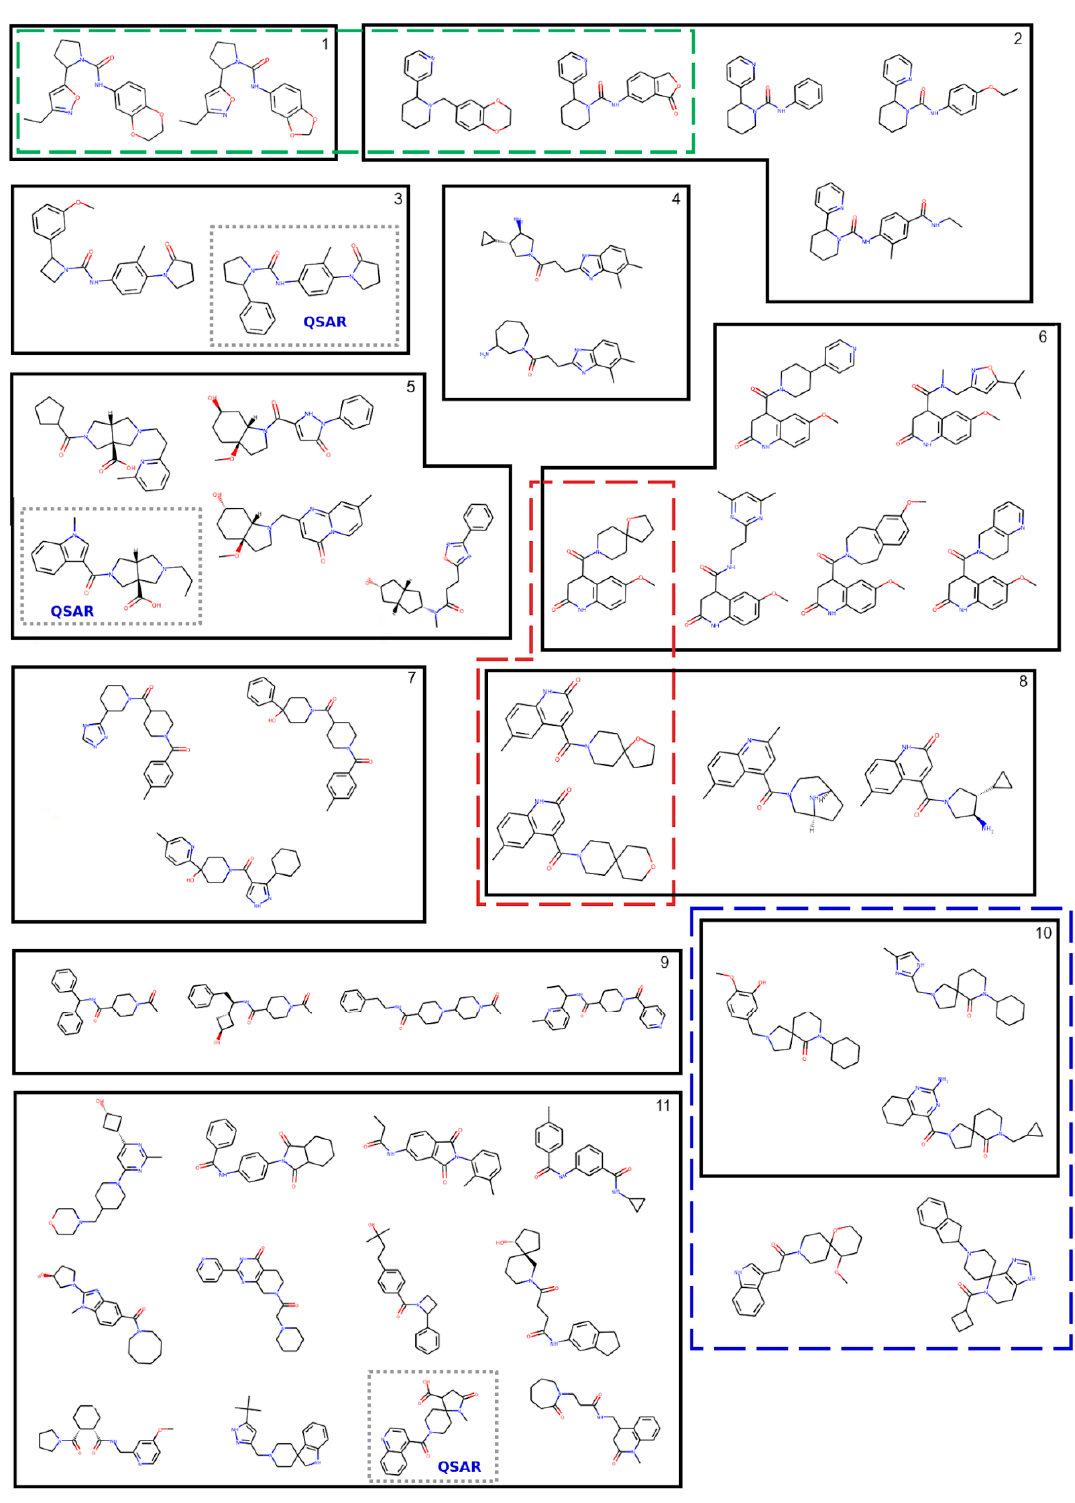
Figure 16. In silico hits selected for in vitro testing (N = 50). Compounds are clustered with hierar- chical clustering applied to Morgan fingerprints. Clusters are generally ordered from top to bottom according to descending inter-cluster median similarity. Cluster 11 should be regarded as the pooled compounds that indicate generally low similarity to the remainder of the compounds. Molecules were aligned by common substructure using the “GenerateDepictionMatching2DStructure” functionality in RDKit, to aid visual comparison of